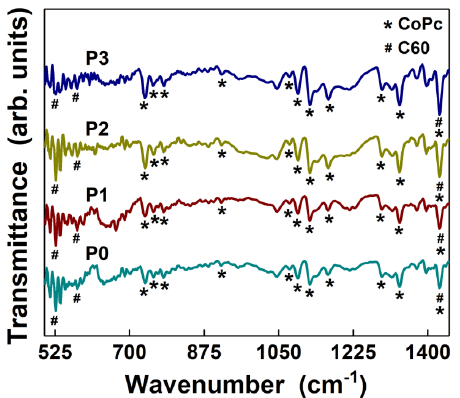
Figure 2. Fourier transformed infrared spectroscopy (FTIR) spectra of the MAPLE-deposited thin films.